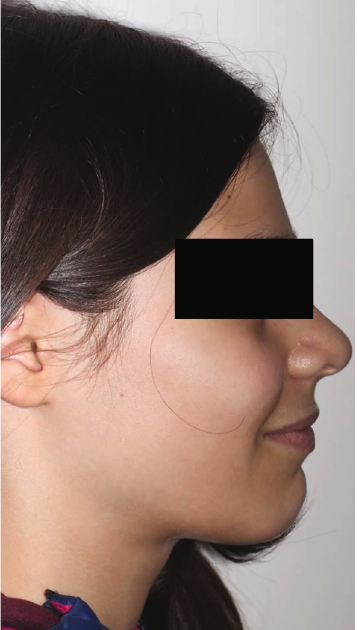
Figure 3: Fränkel